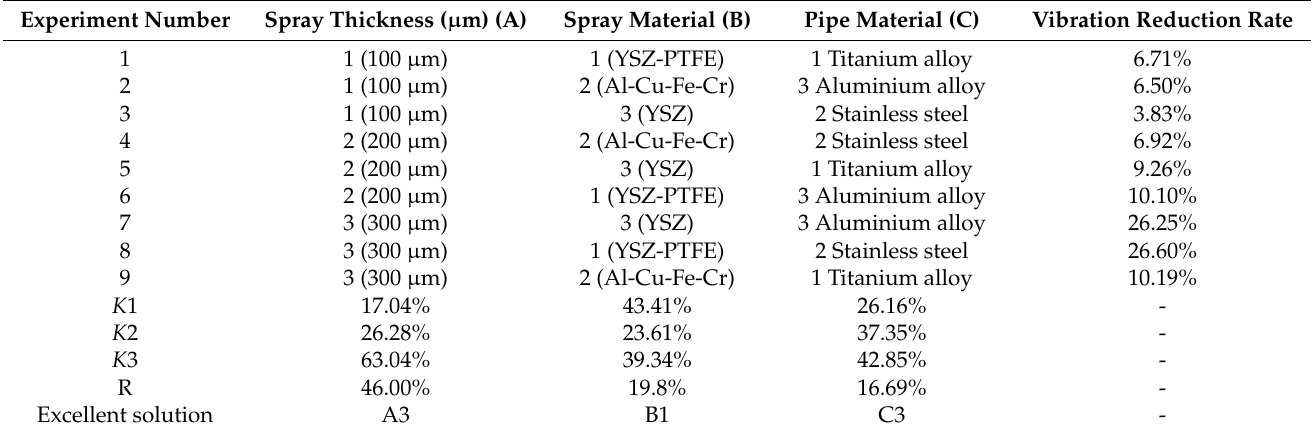
Table 13. Orthogonal experimental results showing the vibration responses of the high-voltage rotor under excitation at constant